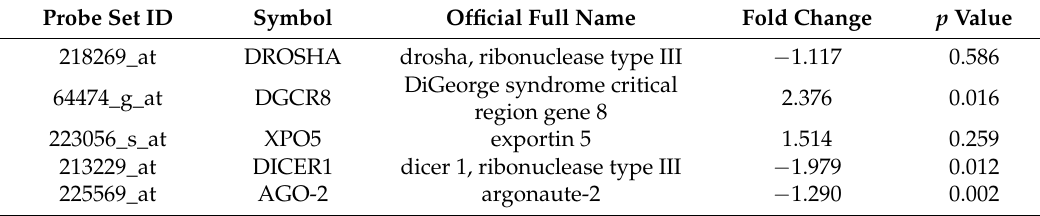
Table 1. Microarray expression data for key miRNA biosynthesis pathway molecules. mRNA expression data were obtained from previously published mRNA microarray data obtained for human umbilical vein endothelial cells (HUVECs) treated with 1 nmol/L estradiol for 24 h. The probe set ID, gene symbol, official full name, p -value, and fold change are shown. These mRNA microarray data are deposited in NCBI’s Gene Expression Omnibus (http://www.ncbi.nlm.nih.gov/geo),